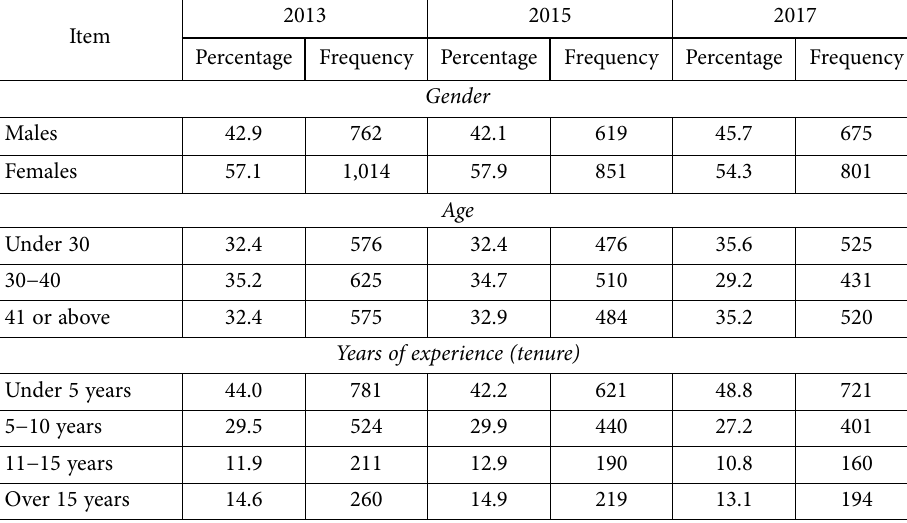
Table 2. The surveyed sample’s selected characteristics (source: Prepared by the authors) 2013 2015 2017 Item Percentage Frequency Percentage Frequency Percentage Frequency Gender Males 42.9 762 42.1 619 45.7 675 Females 57.1 1,014 57.9 851 54.3 801 Age Under 30 32.4 576 32.4 476 35.6 525 30−40 35.2 625 34.7 510 29.2 431 41 or above 32.4 575 32.9 484 35.2 520 Years of experience (tenure) Under 5 years 44.0 781 42.2 621 48.8 721 5−10 years 29.5 524 29.9 440 27.2 401 11−15 years 11.9 12.9 190 10.8 160 Over 15 years 14.6 260 14.9 219 13.1